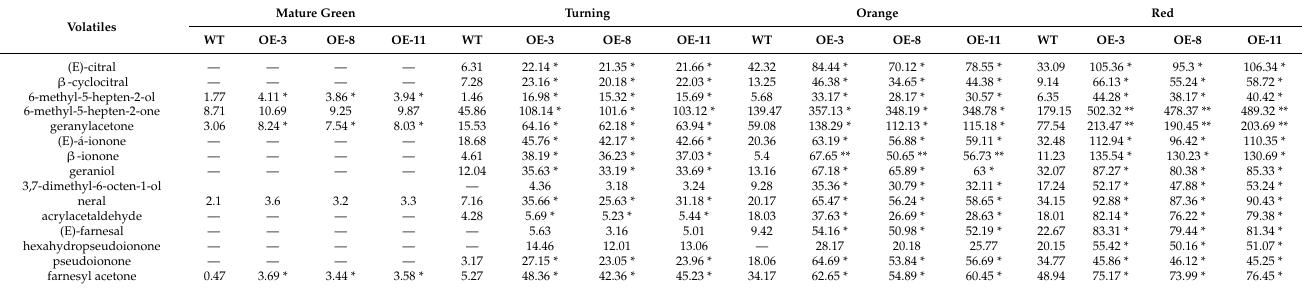
Table 2. OE of SlCCD1A on the contents of carotenoid-derived volatiles in CI1005 tomato fruits ( µ g/kg).